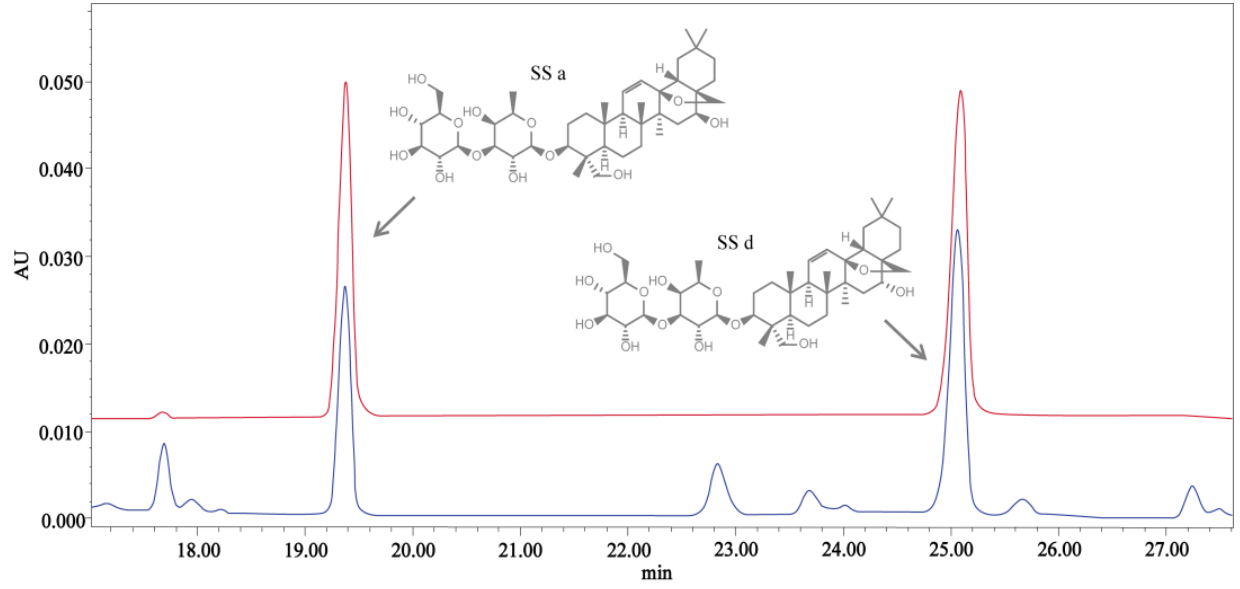
Figure 1. The HPLC chromatogram of two main active components in the Radix bupleuri root. The red color chromatogram of SSa and SSd standards, and the blue color chromatogram of Radix bupleuri . The chromatographic peaks of the two active components are symmetrical, and the retention time is consistent. Table 6. Contents of SSa and SSd in different Radix bupleuri varieties.